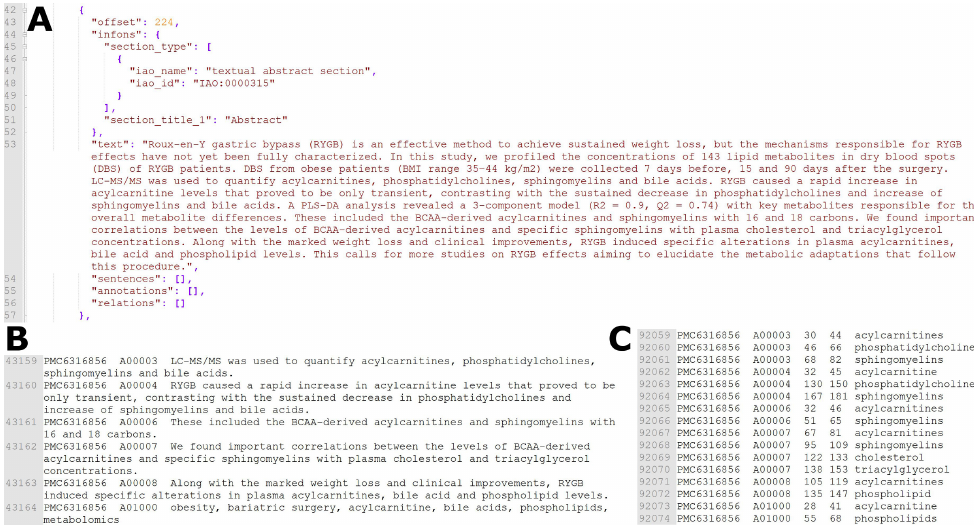
Figure 1. Data processing and corpus generation. ( A ) The Auto-CORPus output (BioC JSON format) for the abstract of PMC6116856. ( B ) Extracted sentences containing annotations in the abstract (part of the metabolomics corpus, training set). ( C ) Rule-based annotations for the abstract sentences (part of the metabolomics corpus, training set).